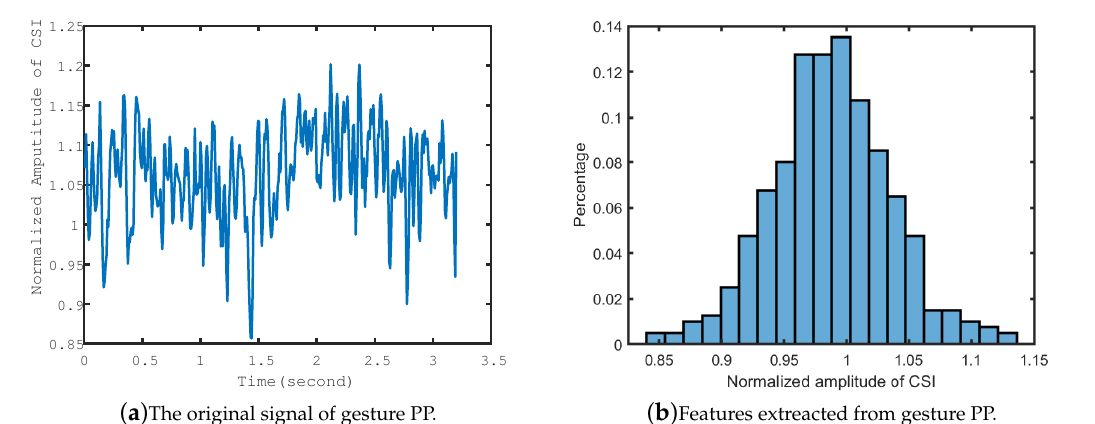
Figure 7. The features of gesture PP, extracted from the original